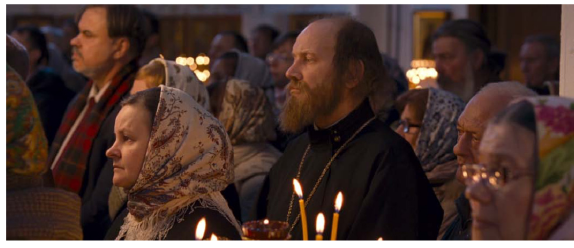
Figure 17. Leviathan (2014).